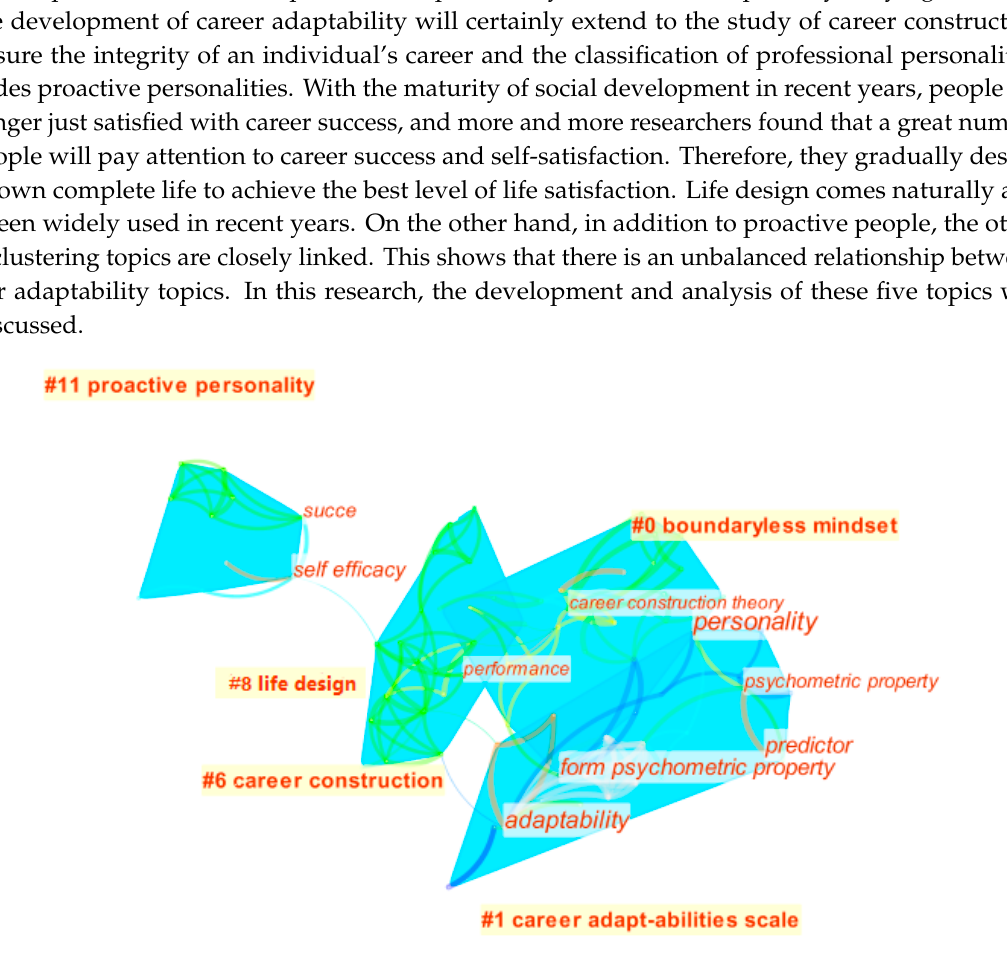
Figure 4. Career adaptability research frontier topics map.